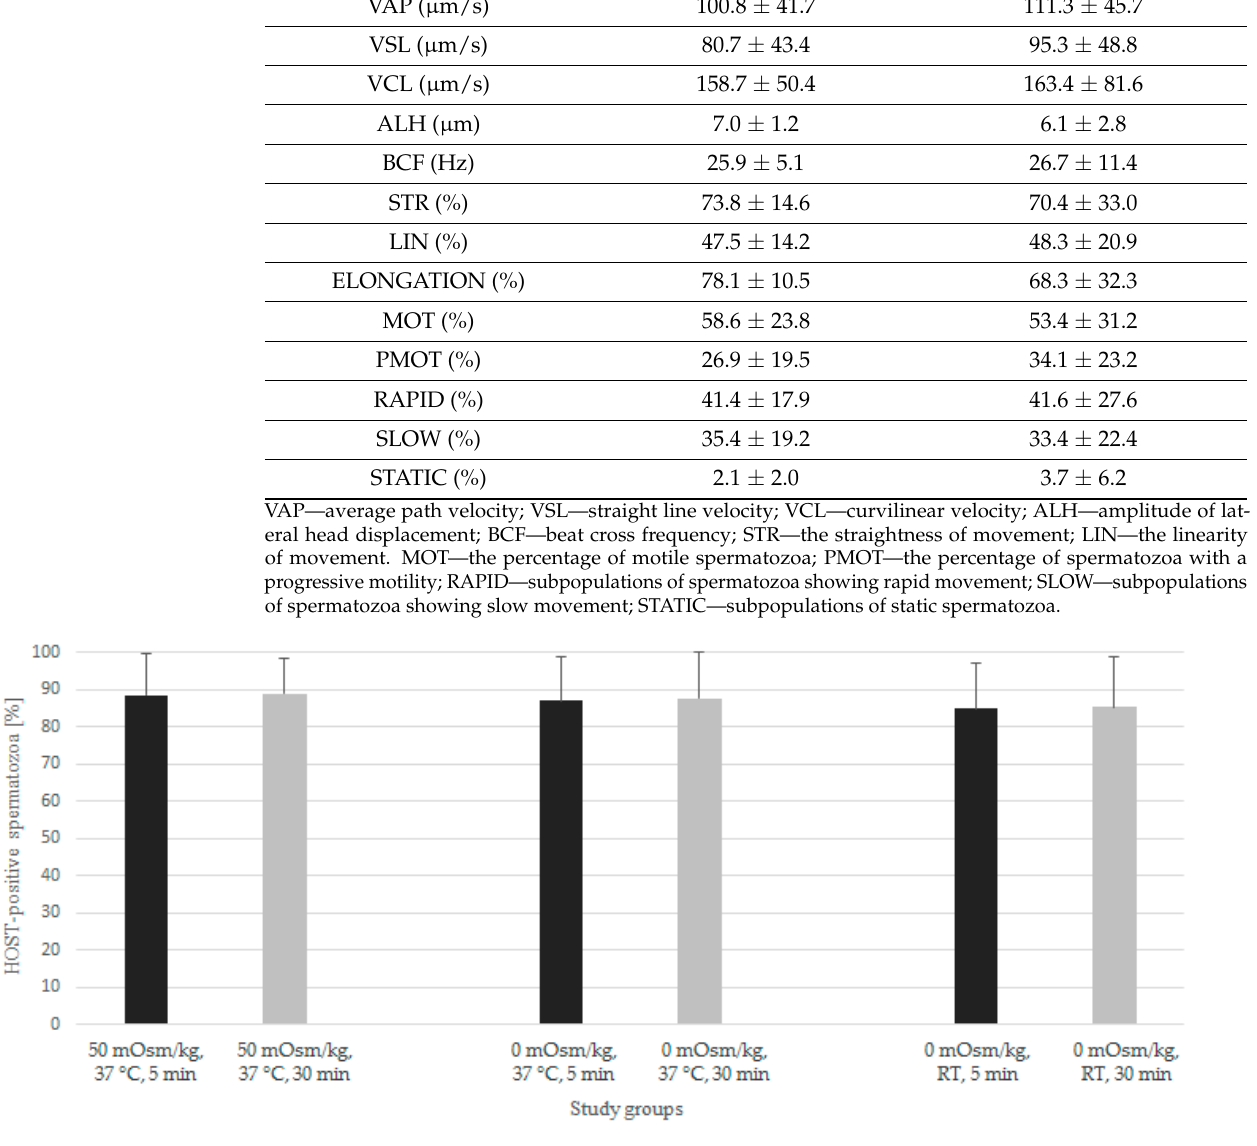
Figure 2. The results of Exp. I—hypo-osmotic swelling test (HOST) performed in different media (50 mOsm/kg fructose or 0 mOsm/kg distilled water) incubated at different temperatures (37 °C or room temperature—RT) for 5 min or 30 min. Results presented as mean ± SD ( n = 13 ). No statistically significant differences were noted.